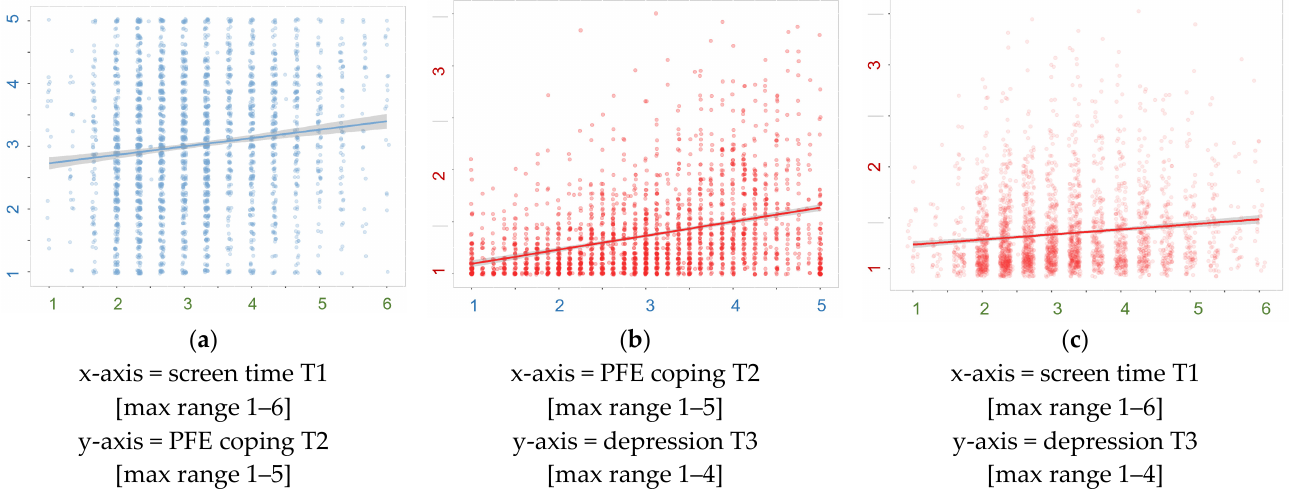
Figure A1. Bivariate plots with regression lines and with 95% CI, estimated from the structural regression, which showed that there was a significant three-way interaction between time, screen time and problem-focused coping (PFE). The figures show the associations of the A, B and C paths in the expected causal directionality. ( a ) Indirect effect of A-path. ( b ) Indirect effect of B-path. ( c ) Indirect effect of C-path.